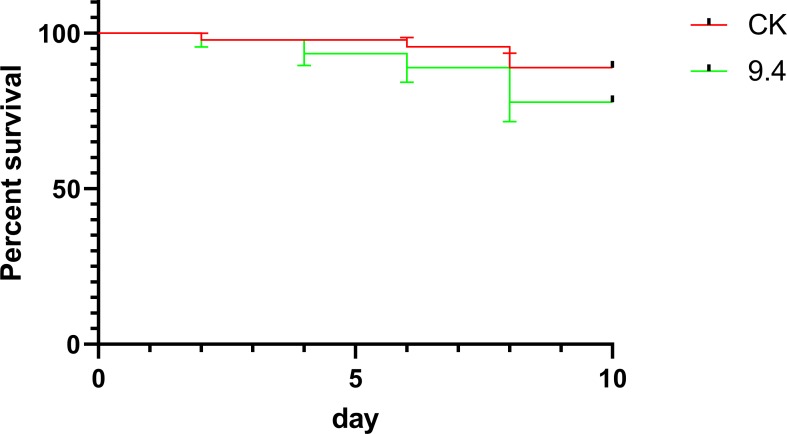
Survival of forager bees subjected to chronic exposure to field-realistic concentrations of amitraz after 10 d.